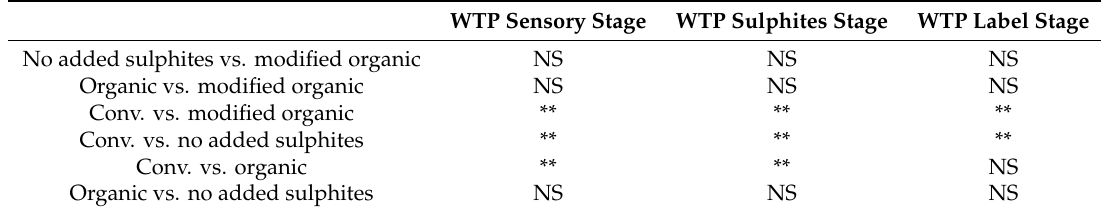
Table 7. Results of Friedman tests for comparison of WTP ranks for each wine and at each stage of the experiment for consumer group 1 (22 consumers). Friedman test, post hoc Nemenyi test; NS: not significant; ** p > 0.01.